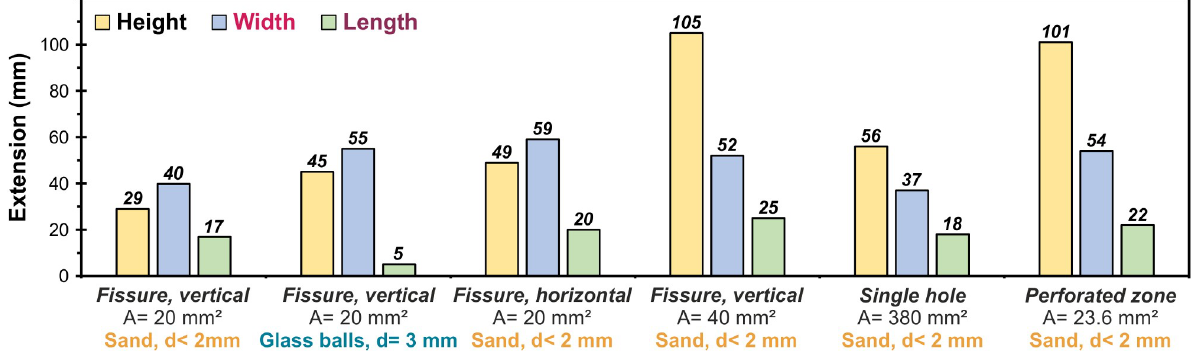
Fig 9. Measurements of formed bodies after paraffin wax loss. The lengths and widths were defined as depicted in Fig 7b, while the height of the solids was measured vertically. A: total surface area of passageways as size of the leakage, d: grainsize of the surrounding material.